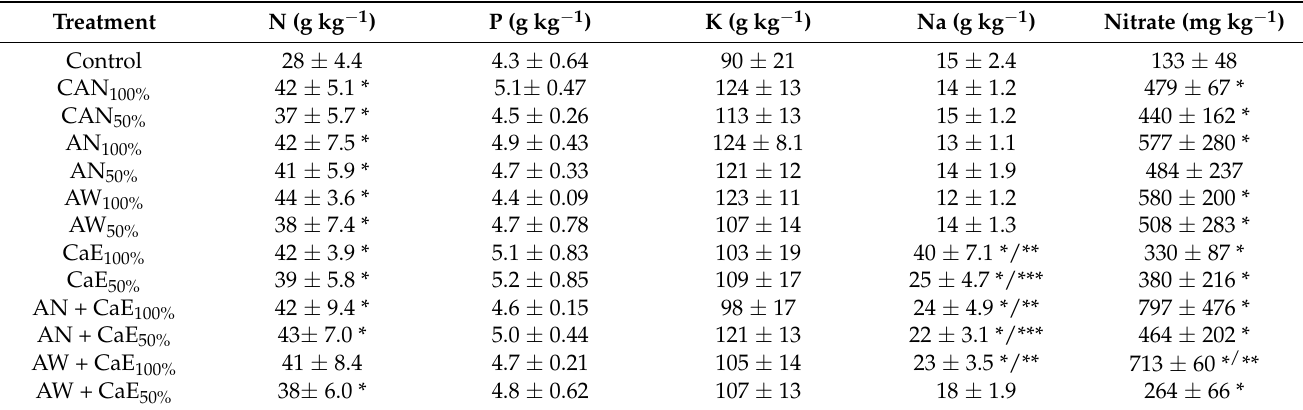
Table 6. Average and standard deviation values of total macro-nutrient (P, K, and Na) and